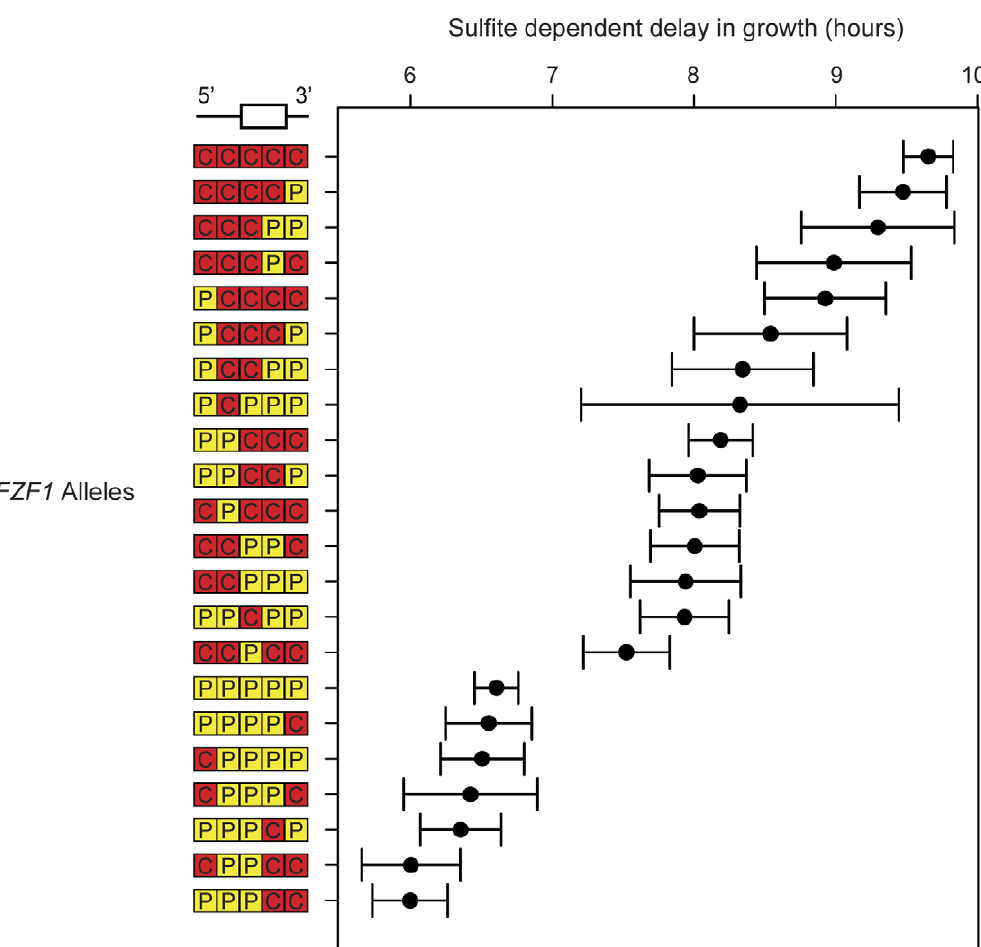
Figure 4. Multiple noncoding and coding changes contribute to sulfite resistance. Sulfite resistance is shown for chimeric alleles of FZF1 from S. cerevisiae and S. paradoxus . Chimera breakpoints are shown in Figure 3 and are labeled 5 9 to 3 9 based on the origin of each region: S. cerevisiae (red, ‘‘C’’) and S. paradoxus (yellow, ‘‘P’’). Error bars show the 95% confidence interval of the mean.